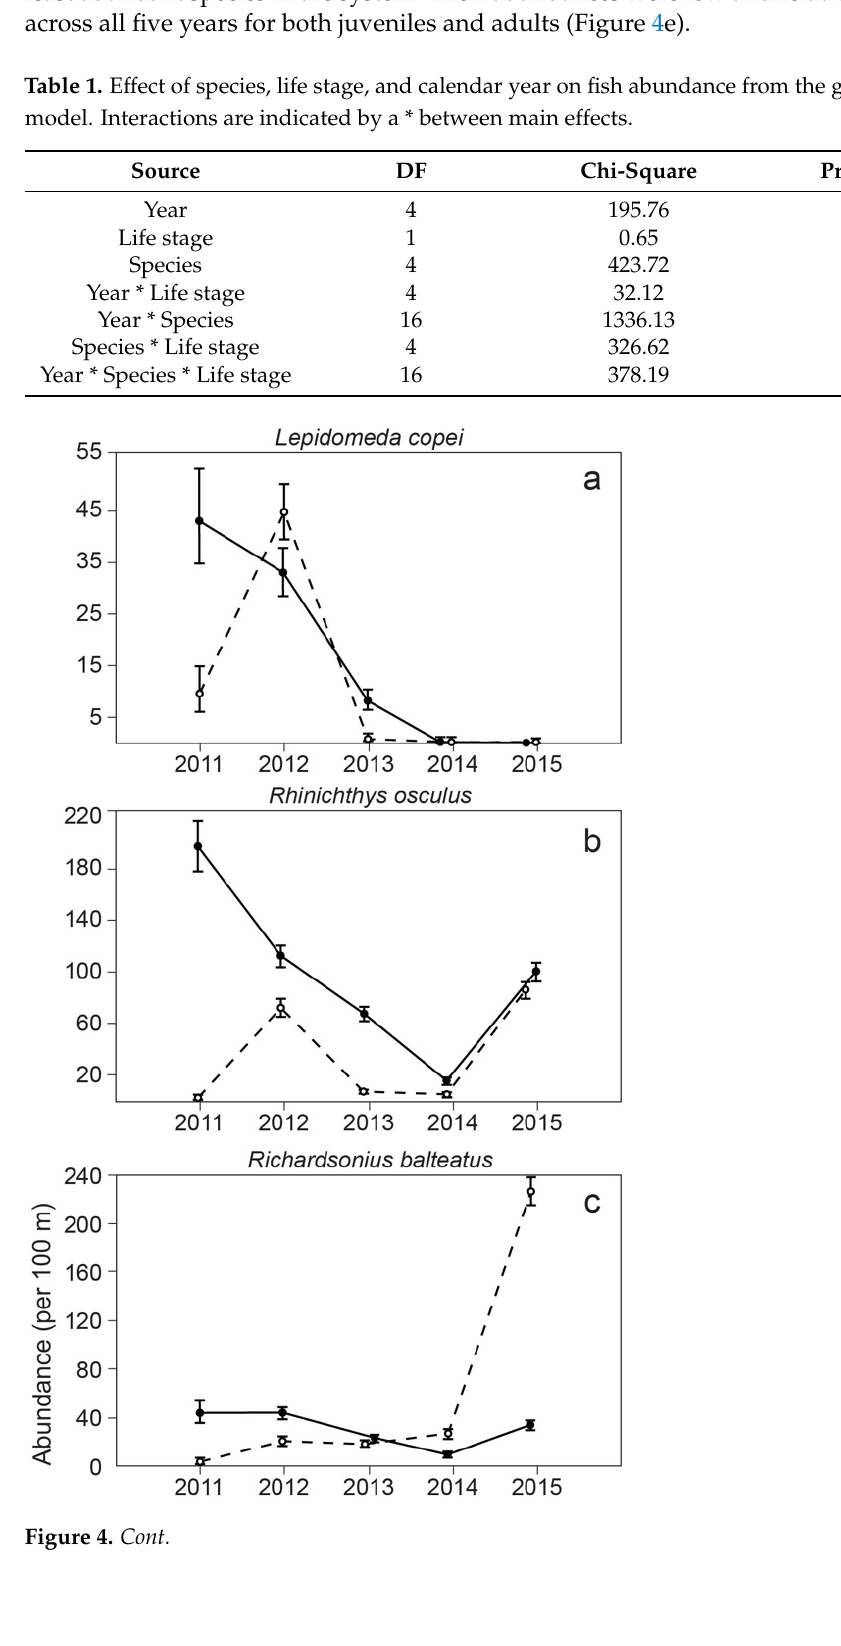
Figure 4. Mean fish abundances by species per year for the five species in this study ( a – e ). Error bars are 95% confidence intervals of the mean. Adults are represented by the solid line and solid circles, and juveniles are represented by the dashed line and open circles.